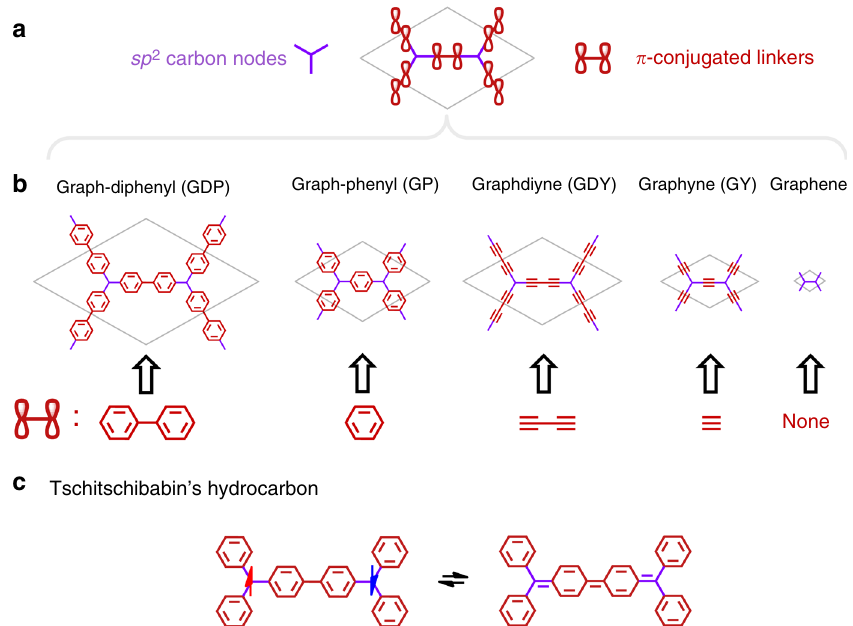
Fig. 1 PGOD chemical structures. a Basic covalent skeleton composed of triply bonded sp 2 carbon atoms (purple) and π -conjugated linkers (red). b Series of graphene and four PGOD materials with different π -conjugated linkers. c Schematic representation of the bi-radical (left) and quinoidal (right) Lewis resonance forms stabilized by spin polarisation and structural distortion, respectively, in the Tschitschibabin ’ s hydrocarbon. Note: Hydrogen atoms in phenyl rings are omitted for